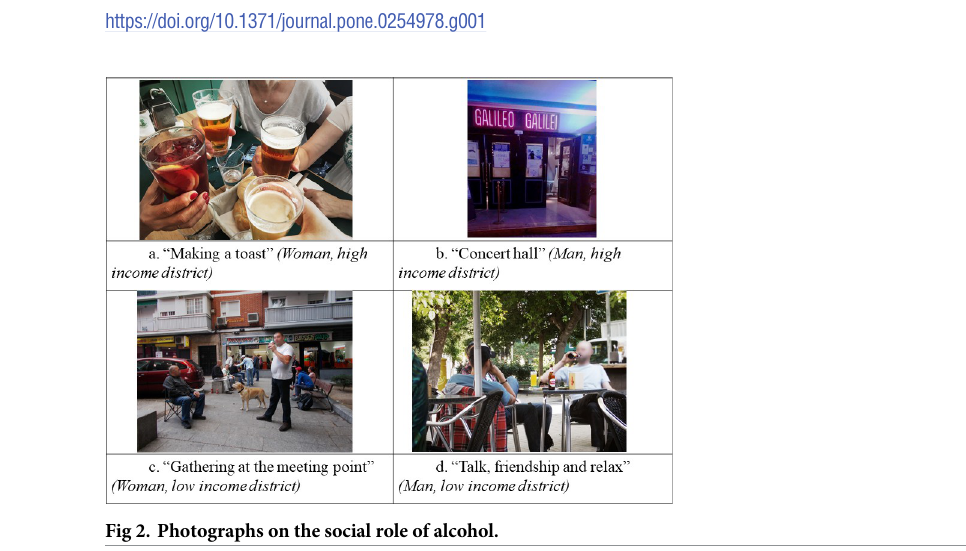
Fig 1. Photographs on alcohol advertising and promotion.